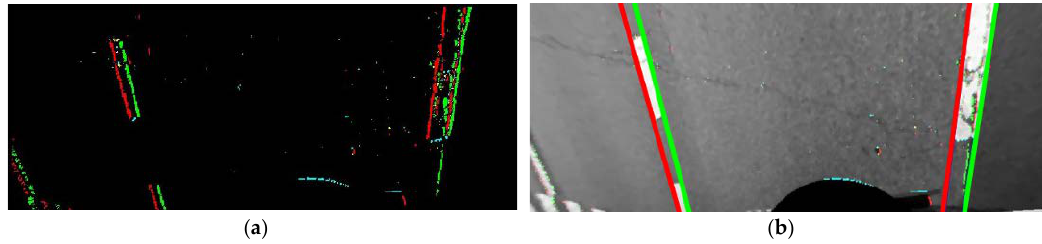
Figure 5. ( a ) Edge detection and classification result (red: rising edge pixels, green: falling edge pixels); ( b ) Lane marking detection result (red: lines from rising edge pixels, green: lines from falling edge pixels).